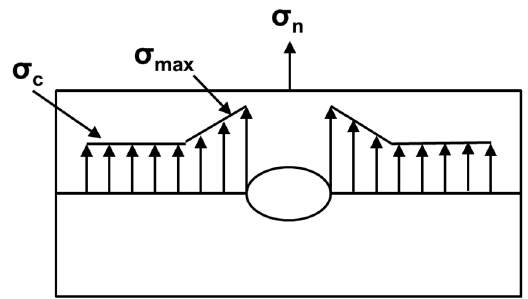
Figure 2. Stress concentration due to elliptical discontinuity.